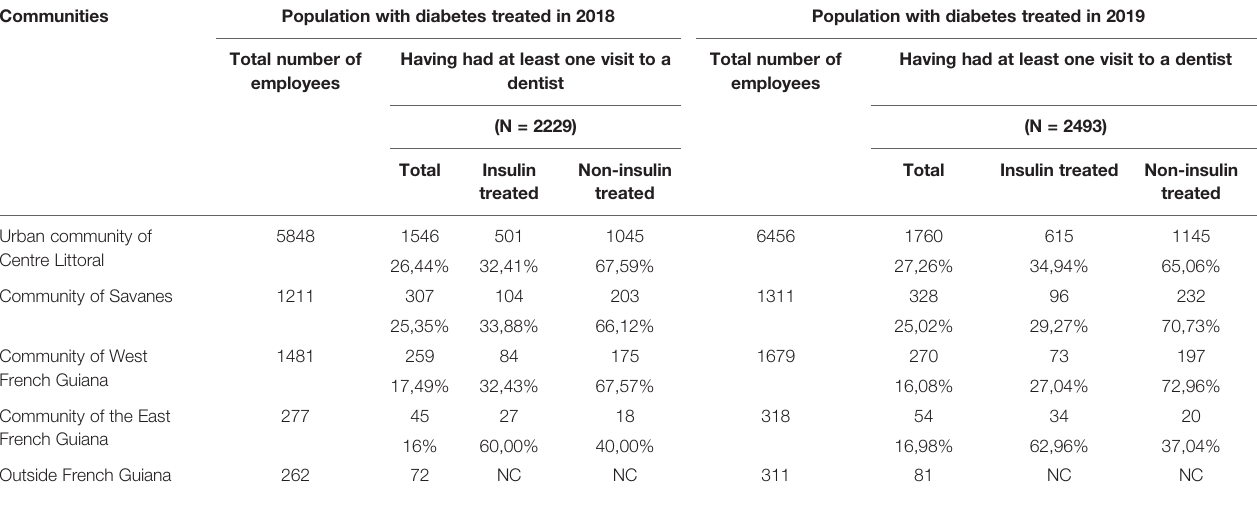
TABLE 2 | Distribution of dentist consultations according to the regions of the territory and according to the insulin therapy of patients with diabetes. Communities Population with diabetes treated in 2018 Population with diabetes treated in 2019 Total number of Having had at least one visit to a Total number of employees dentist employees